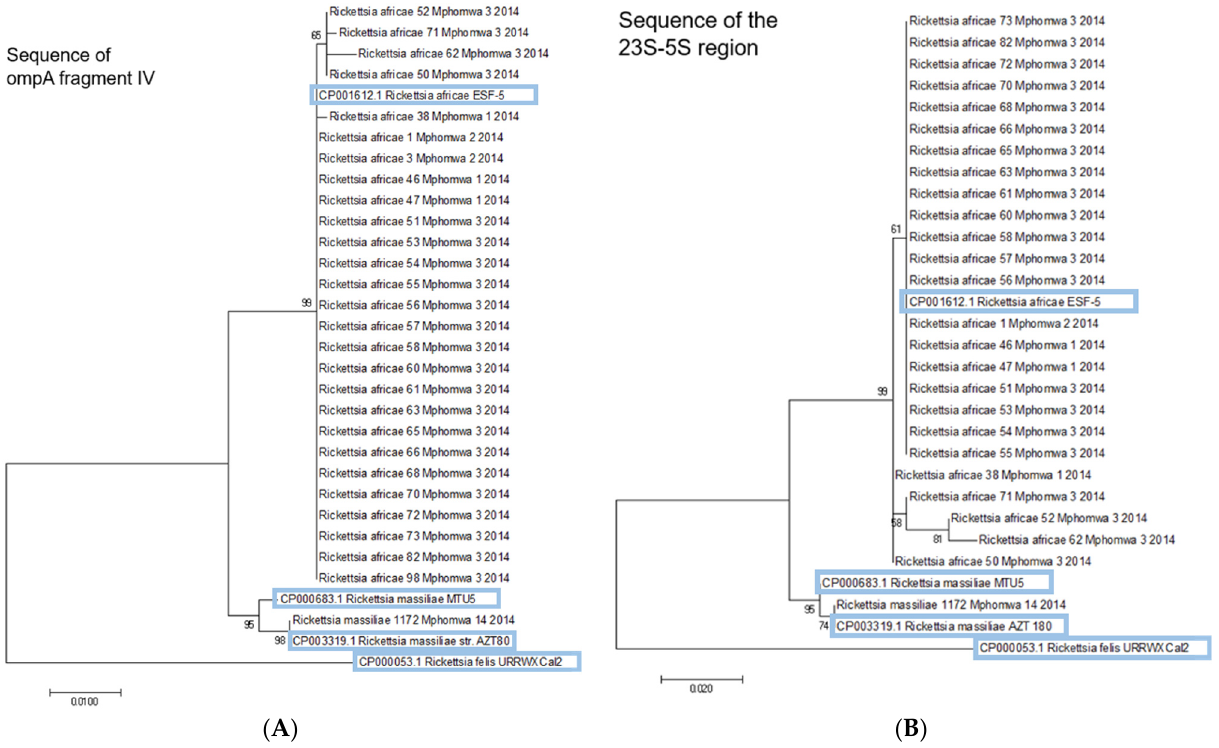
Figure 2. Phylogenetic relationship between Rickettsia spp. by ( A ) ompA gene and ( B ) 23S-5S intergenic spacer region. Legend Figure 2: The number at the branches gives the percentage of trees in which these sequences are clustered together. The bar indicates the percentage of sequence divergence. Label: Rickettsia species | Sample No. | location No (cf. Figure 1) | Date of collection. Table 4. Results of the Chi 2 test and the adjusted Pearson’s coefficient of contingency (P). Degrees